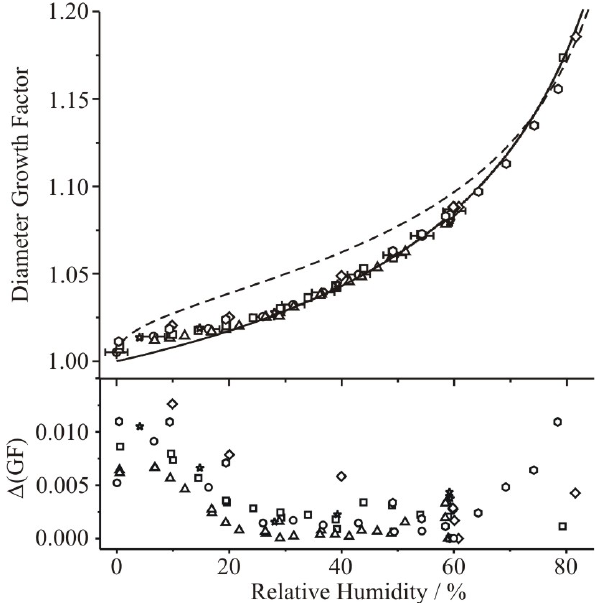
Fig. 6. A comparison of the measured RH variation in diameter growth factor after ∼ 5000s of equilibration with the Zobrist (solid line) and Norrish (dashed line) model predictions of the equilib- rium state. Measurements made on different droplets (6 in total) are shown by different symbols. Although the Zobrist parameter- isation is quantitatively more consistent with the measured data at high RH, the systematic departure from equilibrium behaviour after ∼ 5000s of equilibration with decreasing RH is apparent. The lower panel shows 1 (GF)= | GF(measured)-GF(Zobrist) | . Uncertainties in the RH measurements are shown at the ± 2% level for one experi-